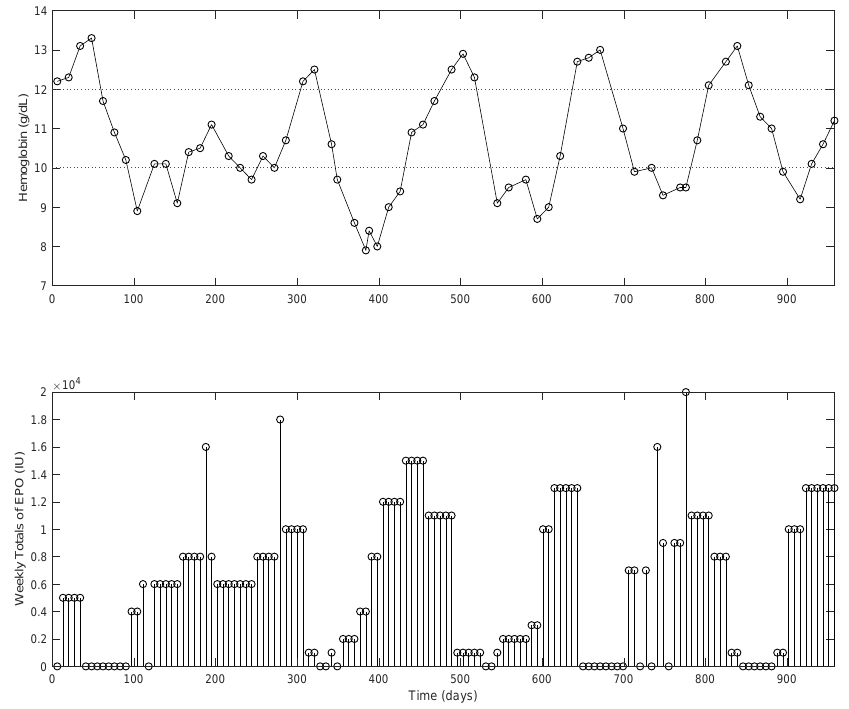
Figure 2. Clinical data for an anemia